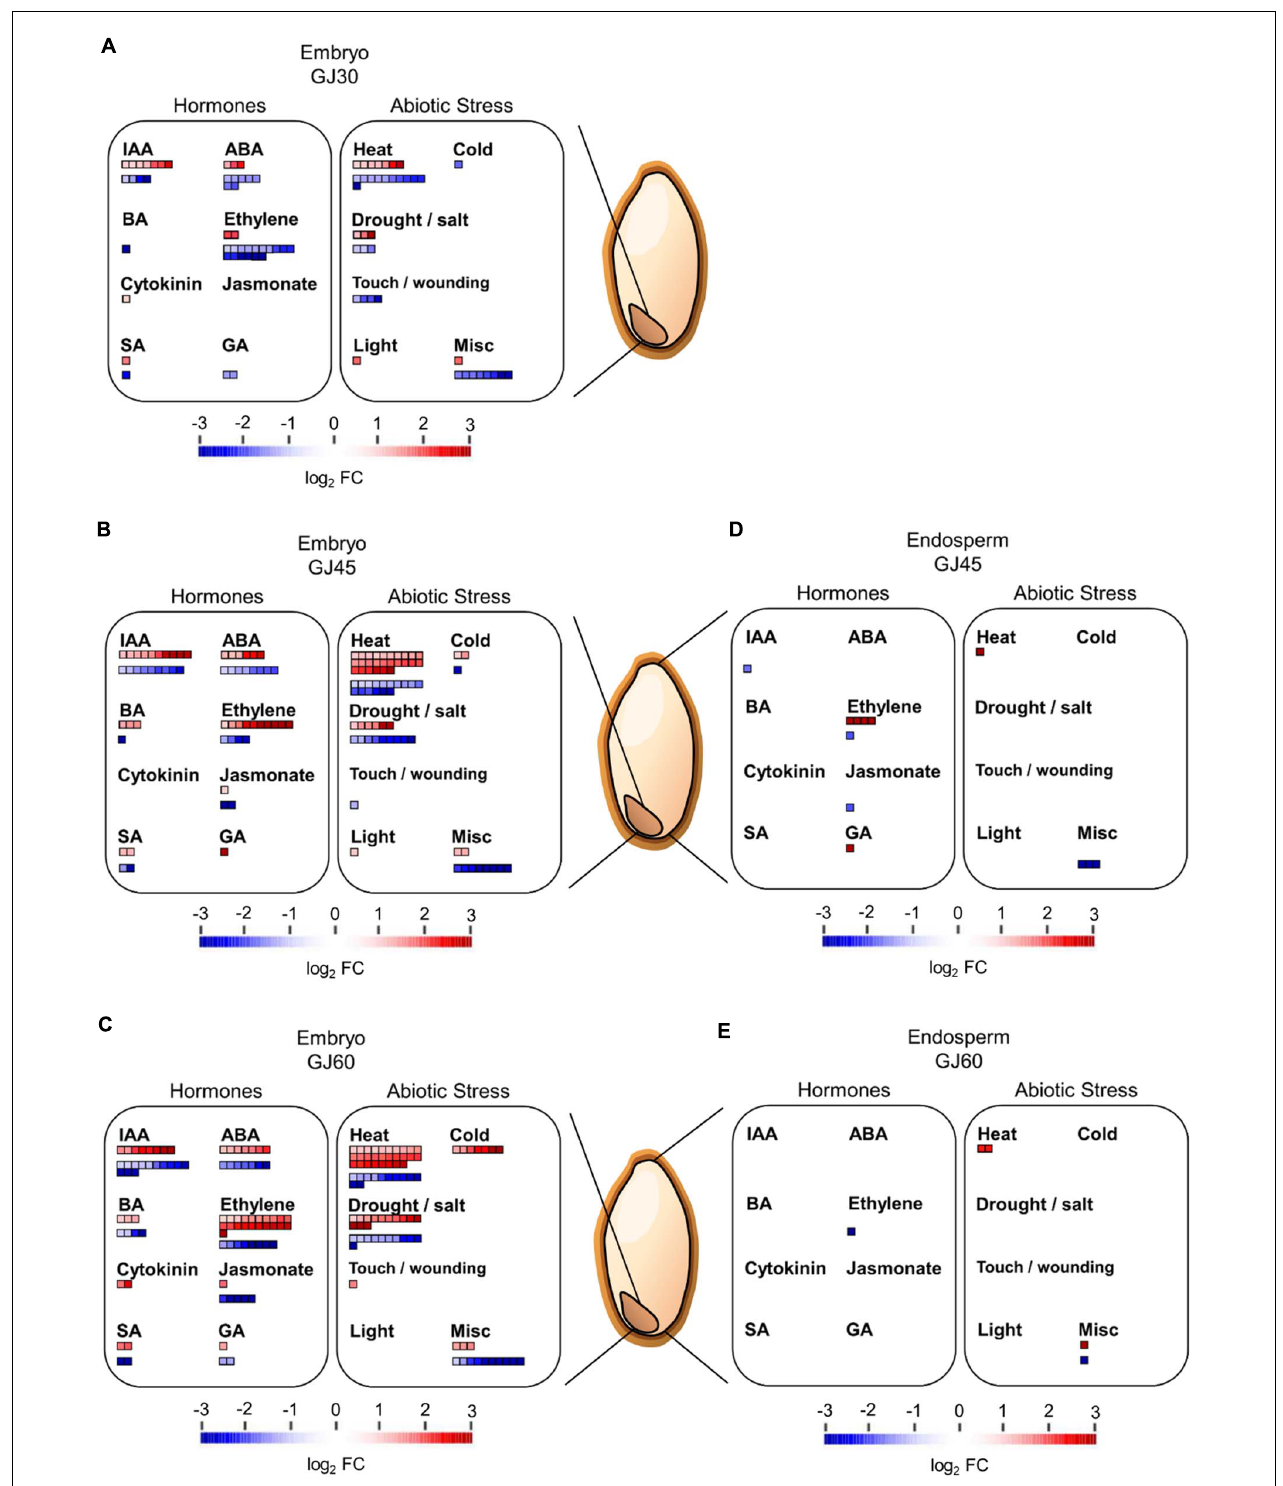
FIGURE 4 | MapMan analysis of differentially expressed genes (DEGs), identified in the embryo and endosperm of Gopum and Jowoon. (A–E) Identification of hormone- and abiotic stress-related DEGs in the embryo of GJ30 (A) , GJ45 (B) , and GJ60 (C) and in endosperm of GJ45 (D) and GJ 60 (E) . The regulation overview and cellular response overview were applied, and the figures were modified from Supplementary Figures 1–4 for DEGs related to hormones and abiotic stress.